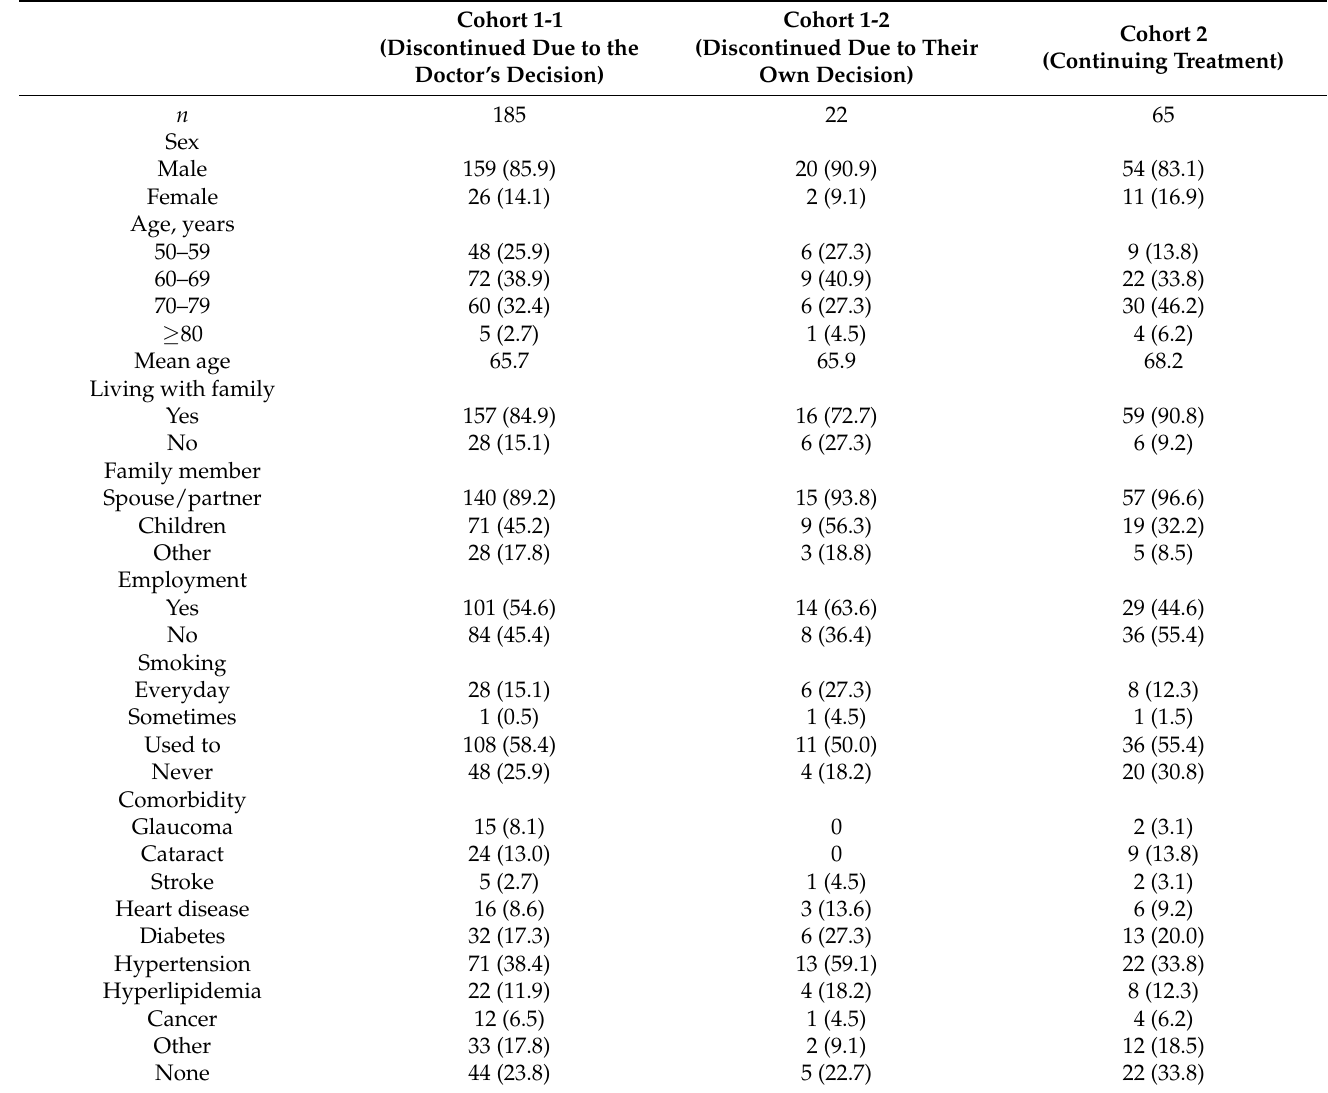
Table 1. Patient